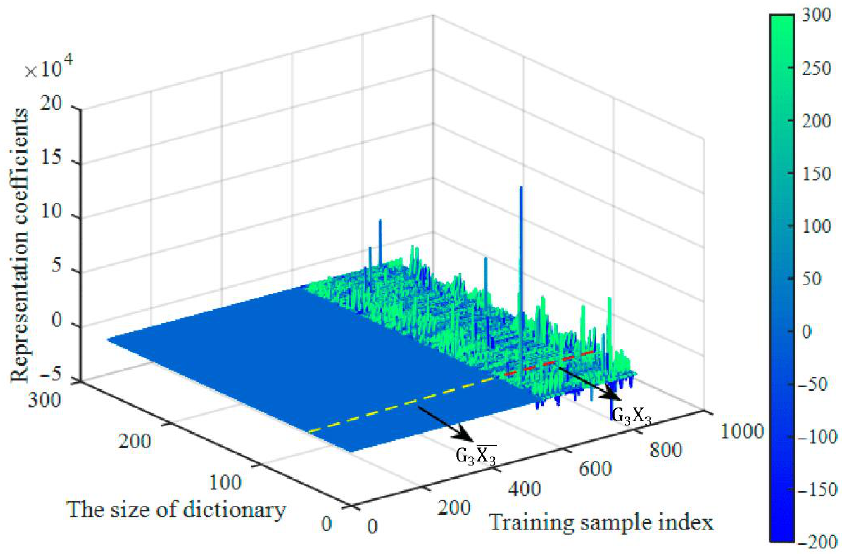
Table 2. The coherence between 𝑆 𝑖 and 𝐺 i .